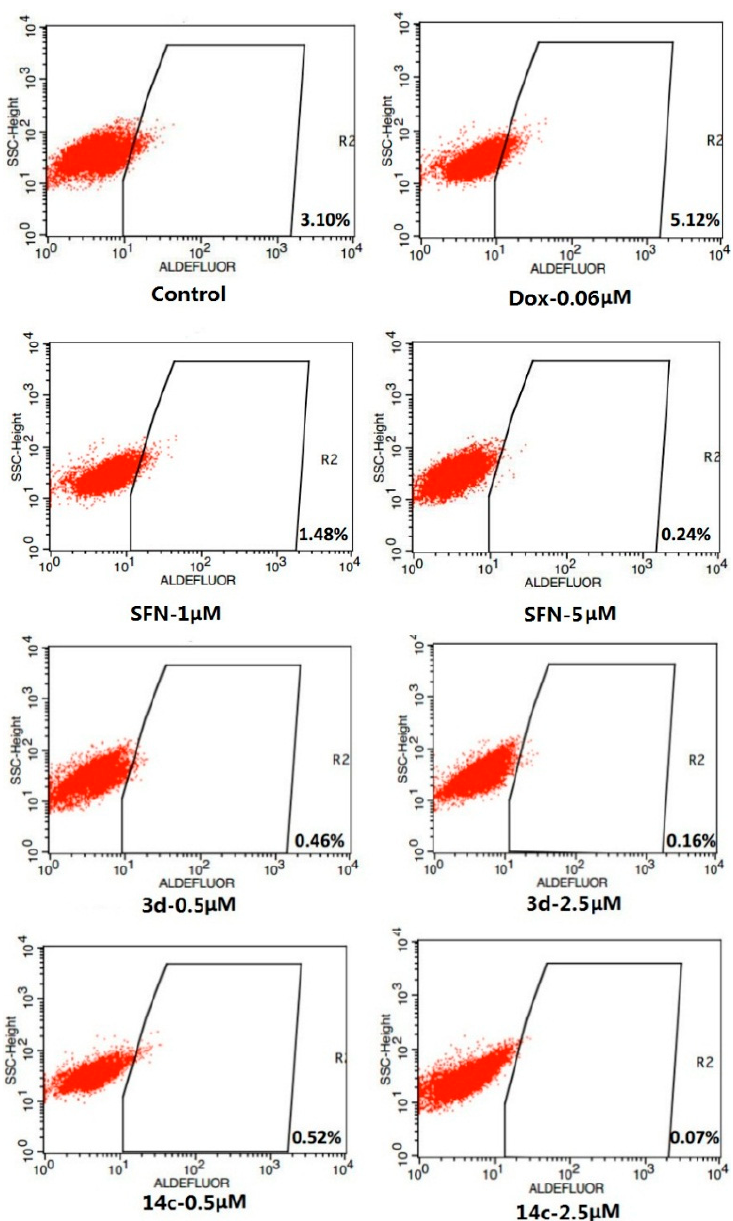
Figure 2. Inhibitory effects of SFN, 3d and 14c on ALDH-positive cell subpopulation.